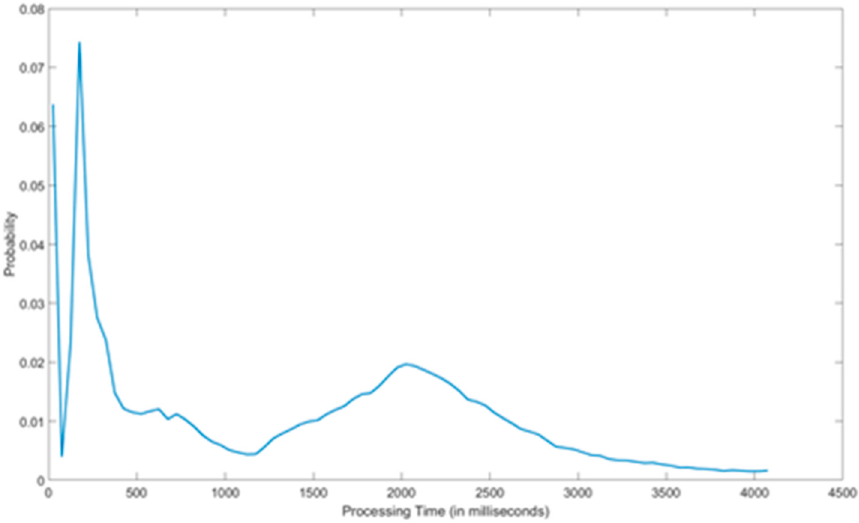
Figure 11. Probability Density Function of processing times for observations’ writings.